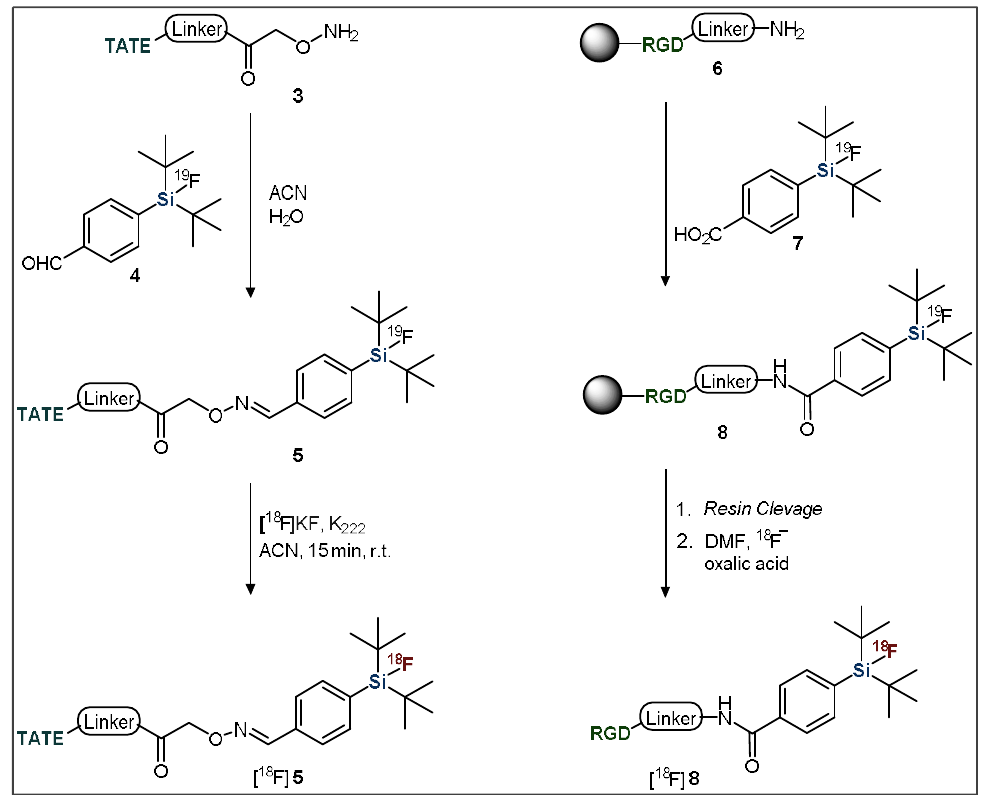
Figure 3. General methods for the introduction of SiFA building blocks to targeting vectors. TATE = Tyr 3 -octreotate; RGD = arginine-glycine-aspartate.